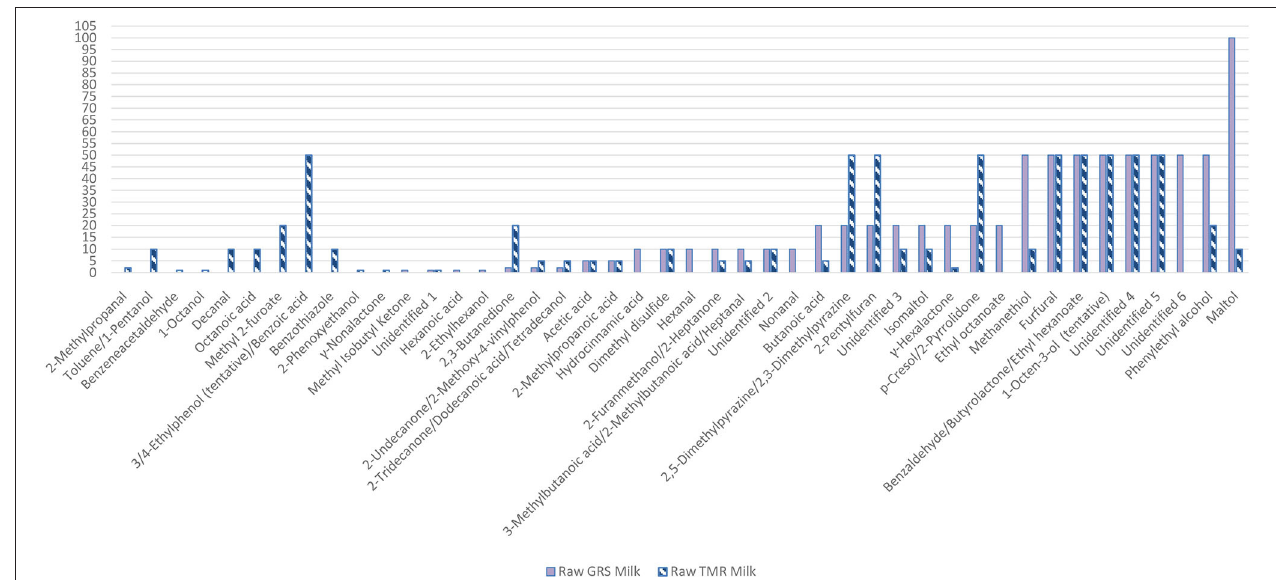
FIGURE 3 | A bar chart illustrating the aroma extraction dilution analysis (AEDA) factor dilution values for the 44 volatile organic compounds identified via gas-chromatography olfactometry in raw grass milk (GRS) and raw TMR milk; range: 0–100. The higher the FD, the more odour intense the compound